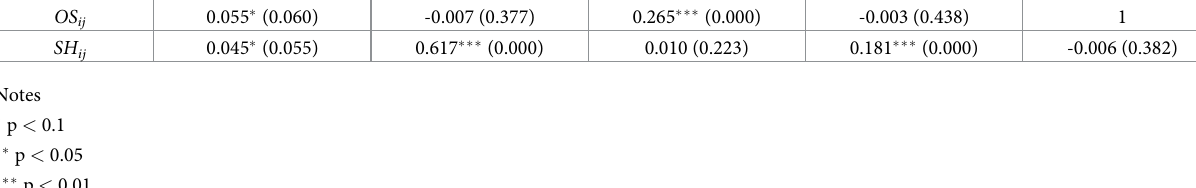
the influence of structural holes on technological convergence, based on patent cooperation networks. First, we use the 52 × 52 J matrix as the dependent variable for measuring the tech- ij nology convergence network, in which the horizontal and vertical axes are permuted 2,000 times. The independent variables are SH and (SH square) , the moderating variables are PC ij ij ij and GD , and the control variables are PS and OS . We perform QAP analysis on the above ij ij ij co-occurrence matrix using Ucinet software. We estimated a total of seven models in Table 7. Specifically, Model 1 includes only control variables. Models 2 and 3 examine the direct effect of structural holes on technology conver- gence. We construct a quadratic matrix of the structural hole constraint index ( SH square) . ij Model 3 reveals a U-shaped curve relationship between the structural hole constraint index and technology convergence. Models 4, 5, and 6 show the moderating effect of the degree of patent cooperation and the distance of patent cooperation, as evidenced by the interaction effect with the quadratic terms of the structural hole constraint index and the structural hole constraint index. Model 7 is the full model with all variable matrices.